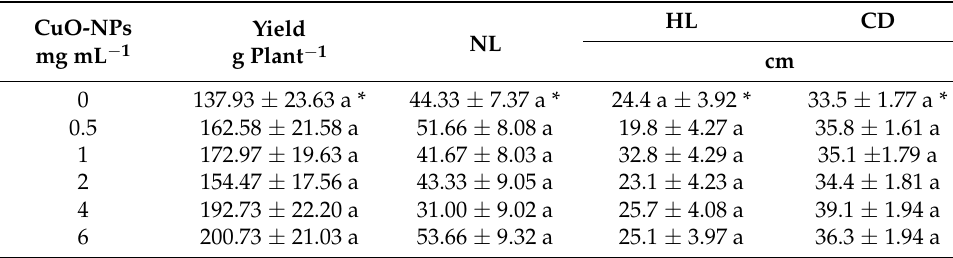
Table 1. Yield components due to the effect of the different concentrations of CuO-NPs applied via